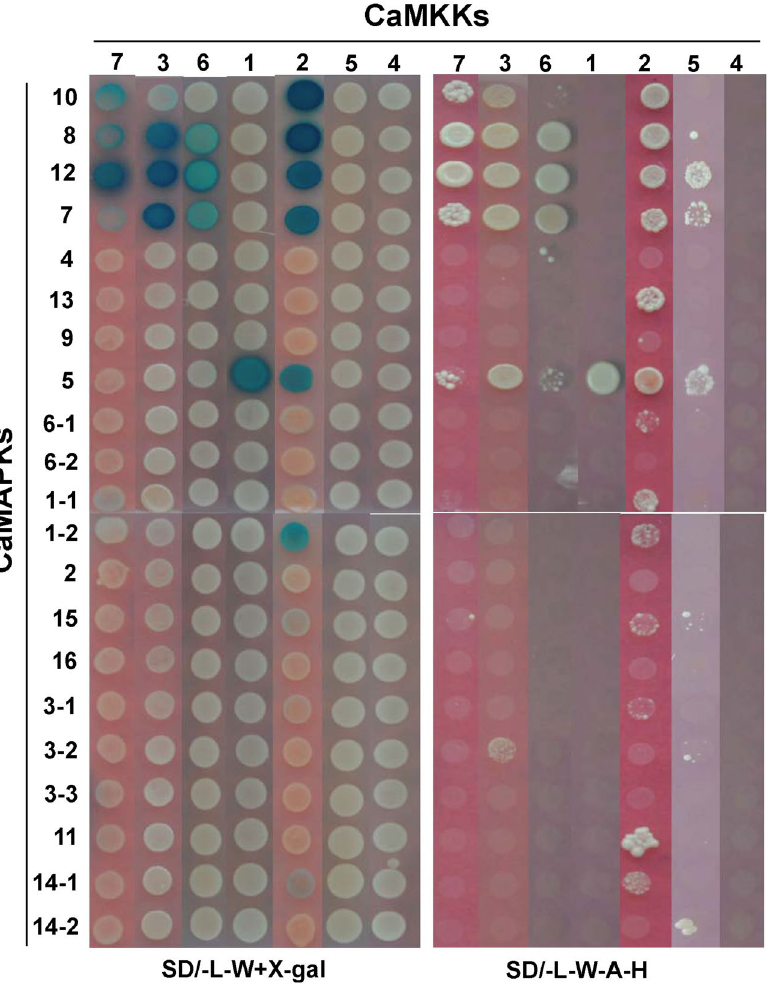
Figure 3. Interaction analysis of chickpea MKKs and MAPKs by yeast two-hybrid. Split-ubiquitin based Y2H system was used for checking interactions between 7 CaMKKs and 21 CaMAPKs in 147 possible combinations. The CaMKKs were cloned in pGDHB1 and CaMAPKs in pGPR3-N vector. The plates were photographed after 48 h of yeast growth. Strong protein-protein interactions showed growth on SD/-L-W-H-A media and blue colour after X-gal overlay assay. Weak interactions showed less growth on SD/-L-W-H-A media and light blue colour. Photographs were arranged in an array for comparison and better visualization. Reciprocal interaction assay was also